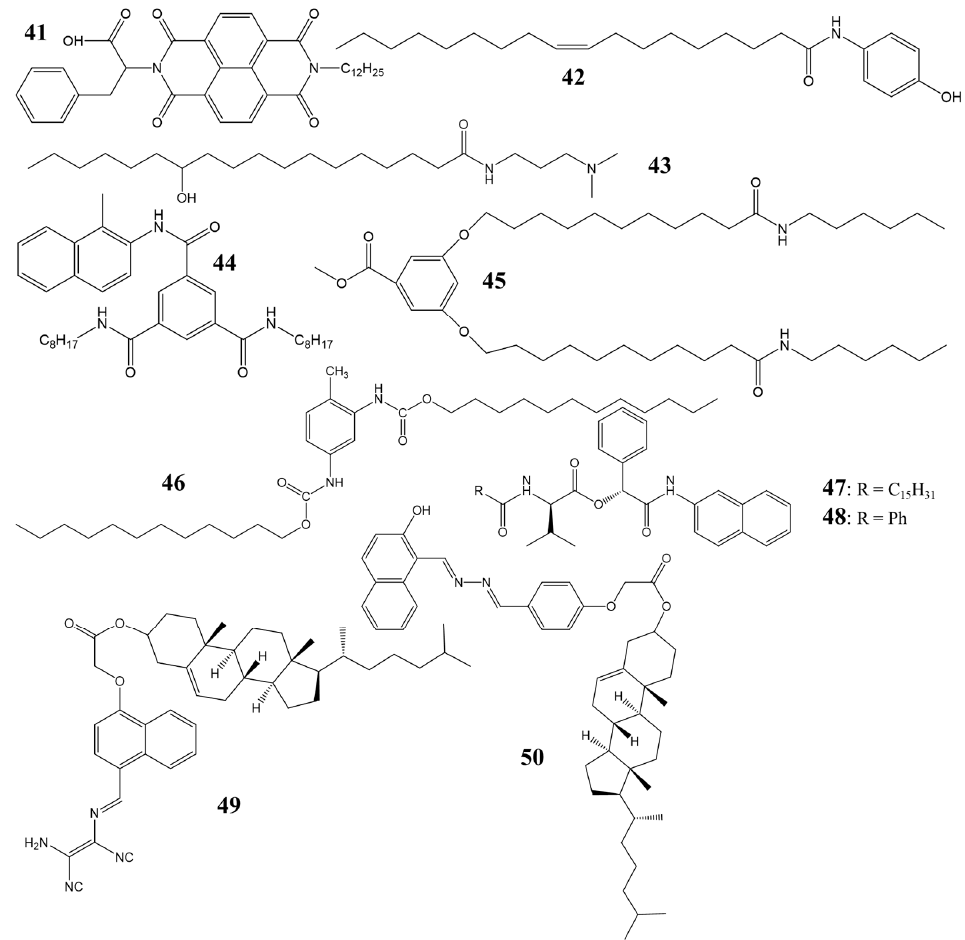
Figure 4. Chemical structures of PSOGs 41 – 50 . According to Li and co-workers [62], the benzene 1,3,5-tricarboxamide based PSOG 44 can be used for not only aromatic solvents and oil recovery but also dye removal. The FTIR and UV analyses indicated that hydrogen bonding and π – π interaction accounted